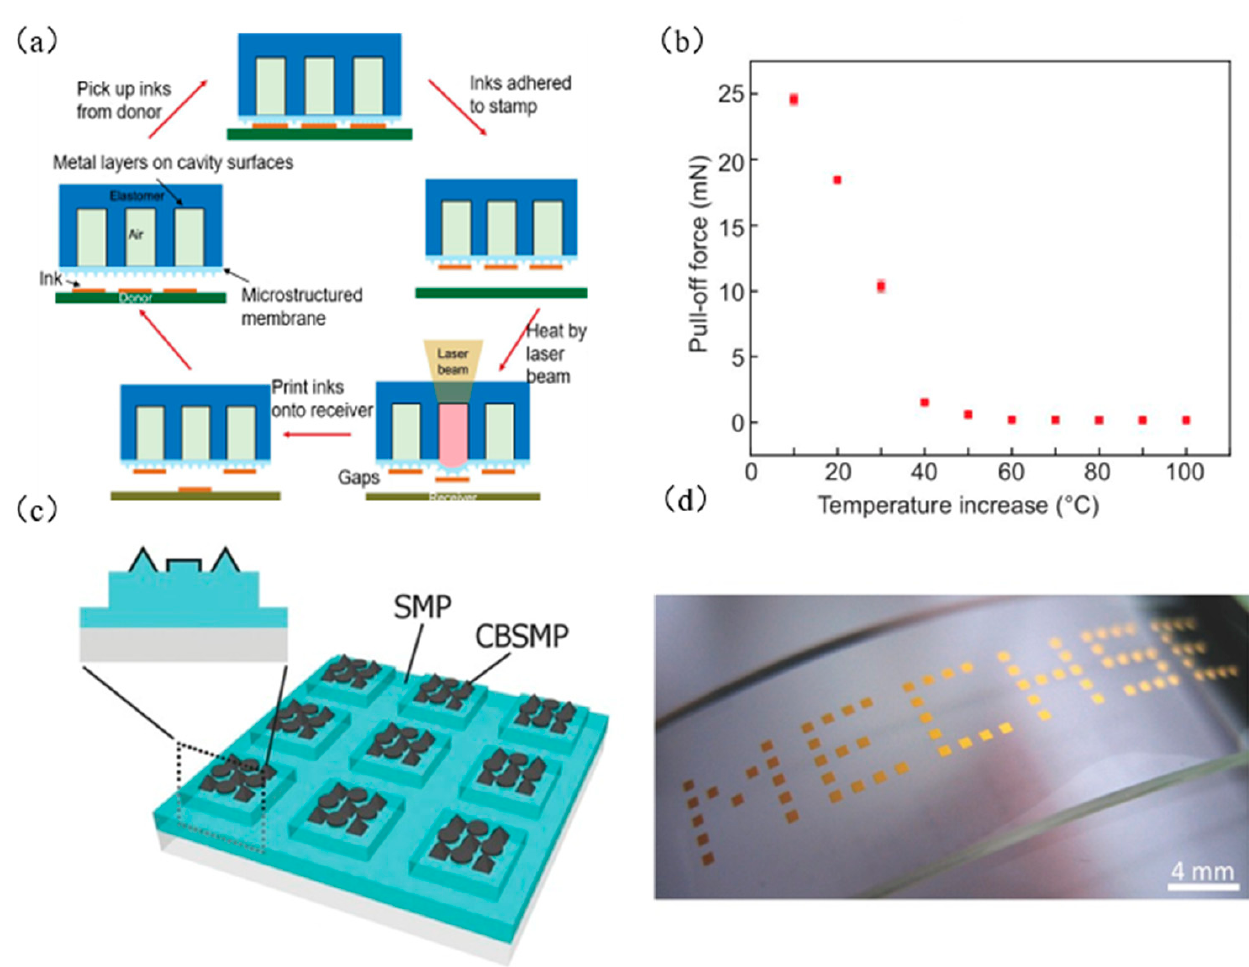
Figure 8. Laser-controlled seal temperature transfer printing technology process diagram and example. ( a ) Specific diagram of laser temperature control transfer printing technology for seal with cavity (reproduced from [39]), ( b ) stress relationship diagram at different elevated temperatures (reproduced from [39]), ( c ) SMP seal design drawing with carbon black composite material (reproduced from [74]), and ( d ) an example of selective printing of gold-plated silicon wafers that do not absorb infrared laser ink (MECHSE: Department of Mechanical Science and Engineering) (reproduced from [74]).